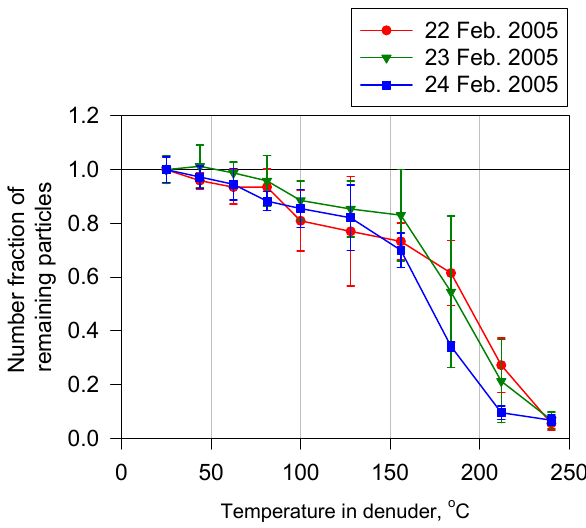
Fig. 4. Typical examples of the relation between temperature and volatility of aerosol particles at Syowa Station on 22–24 February 2005. Error bars show the standard